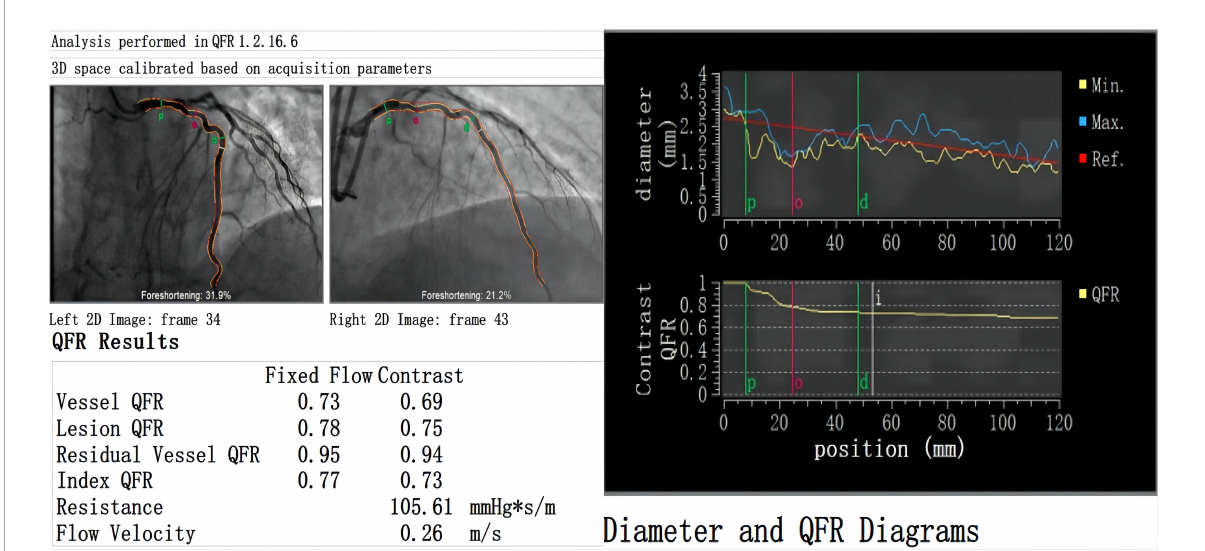
FIGURE1 Case example of QFR report. There is a moderate stenosis (diameter stenosis = 46.4%) with QFR value = 0.69 in a 58-year old male patient. Qm (33 ml/min) and PI (3), the backflow component of TTFM is not evident. Postoperative multislice computed tomography angiography shows patency of the LITA graft.